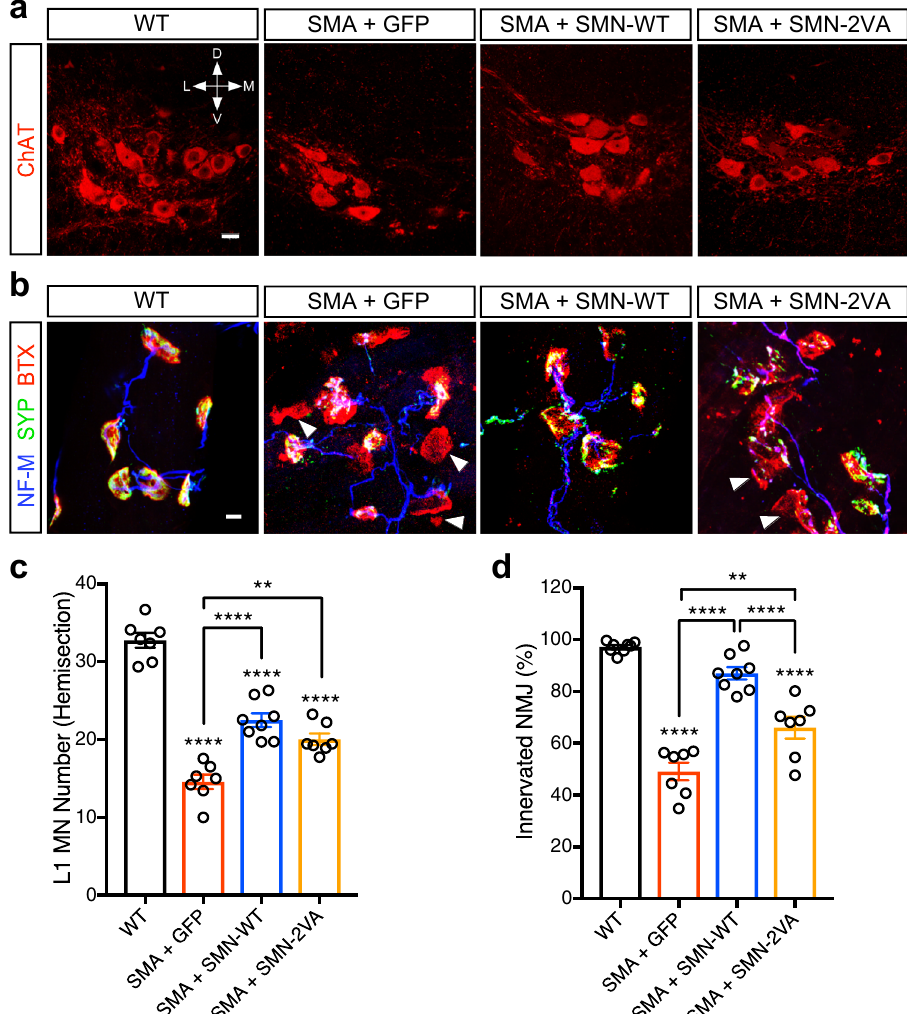
Fig. 7 SIM-less SMN partially rescues motor neuron loss and NMJ denervation in SMA mice. a ChAT immunostaining of L1 spinal cords from WT mice or SMA mice injected with AAV9-GFP, AAV9-SMN-WT, or AAV9-SMN-2VA at P9. Scale bar = 20 µ m. b NMJ staining with bungarotoxin (BTX, red), synaptophysin (SYP, green), and neuro fi lament (NF-M, blue) of quadratus lumborum (QL) muscles from the same groups as in (a) at P9. SMN de fi ciency determines alterations at the NMJ level, affecting their proper innervation (denervated endplates appear as isolated red structures – white arrowheads – without colocalization between bungarotoxin and synaptophysin). Scale bar = 10 µ m. c Total number of L1 motor neurons in the same groups as in ( a ) at P9. Data represent mean and SEM (WT n